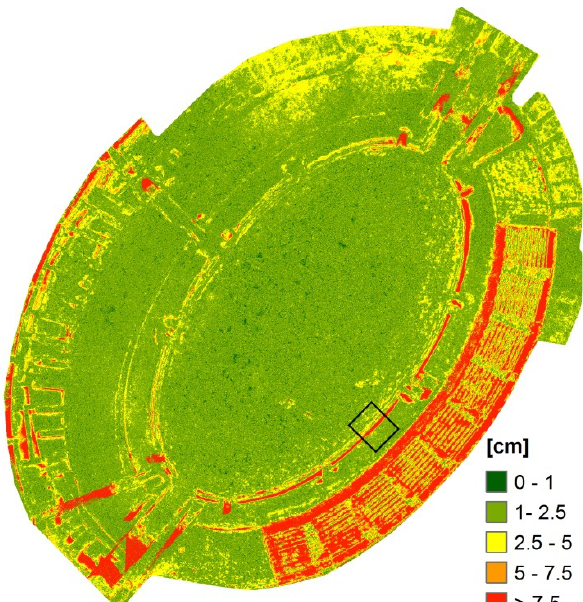
Figure 11: Nadir plus Oblique vs